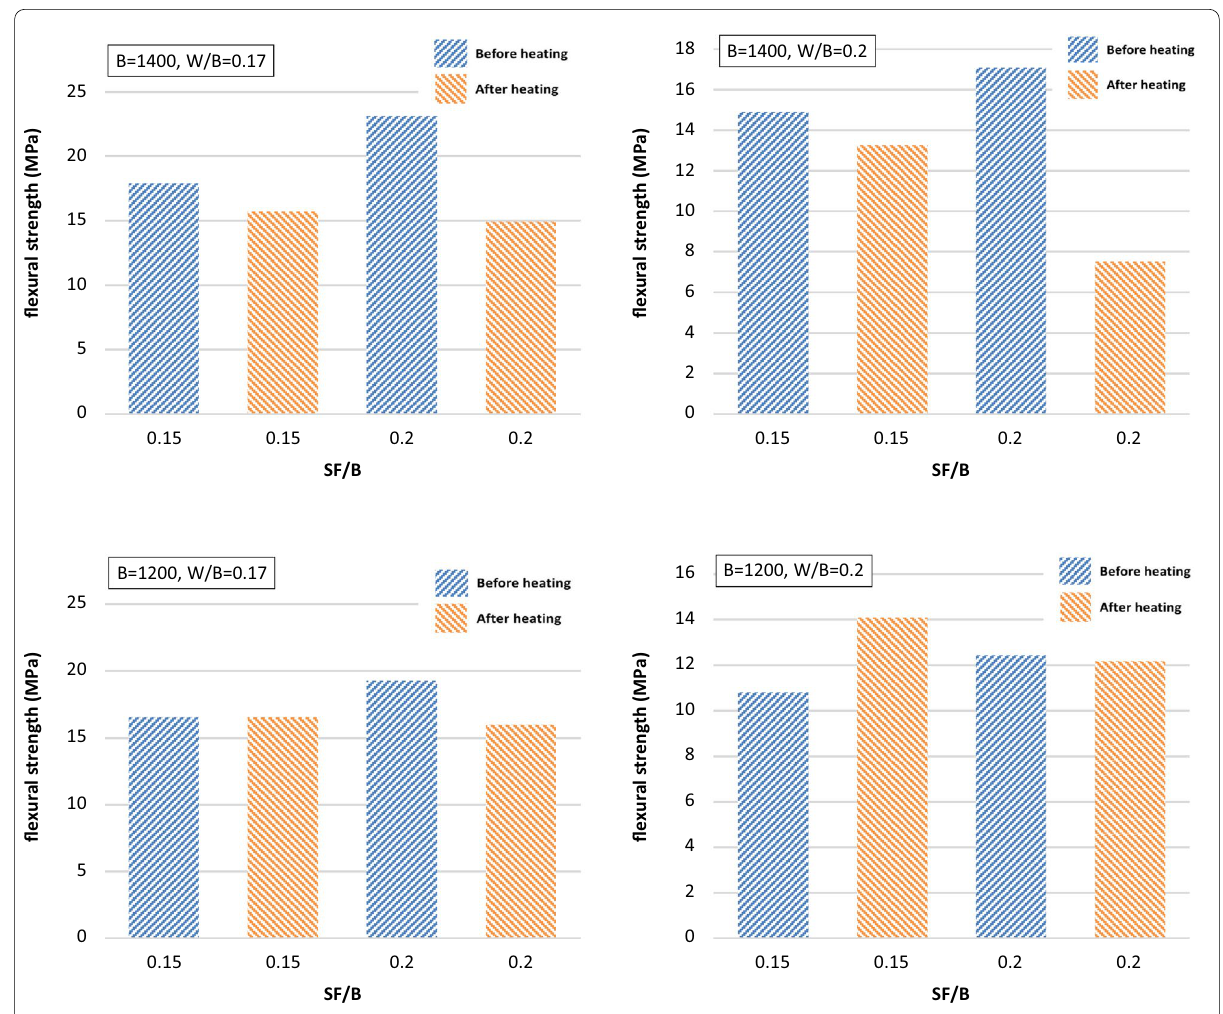
Fig. 12 Variation of flexural strength of concrete mixes against SF/B before and after